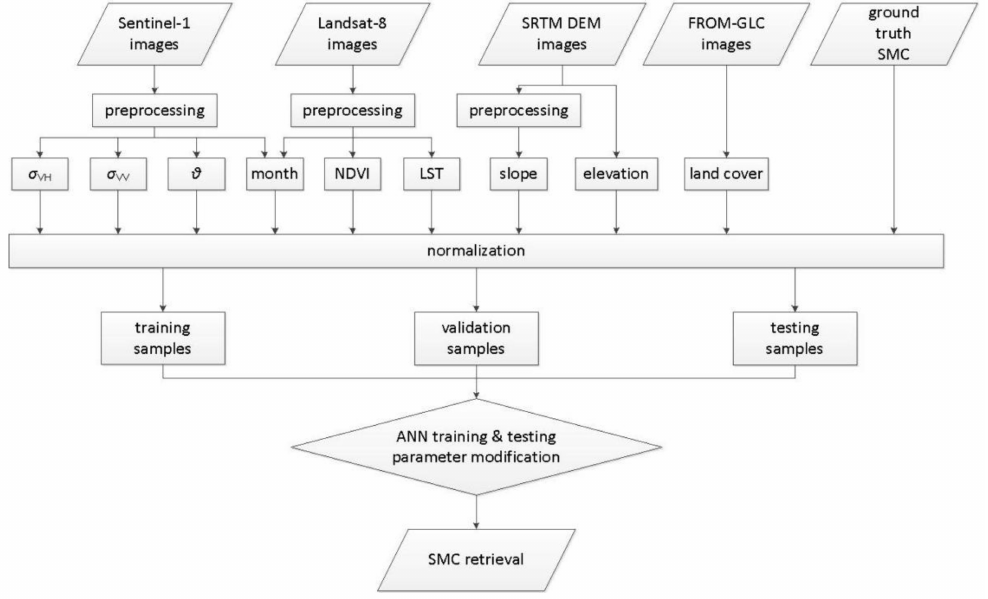
Figure 3. Flowchart of the SMC retrieval by